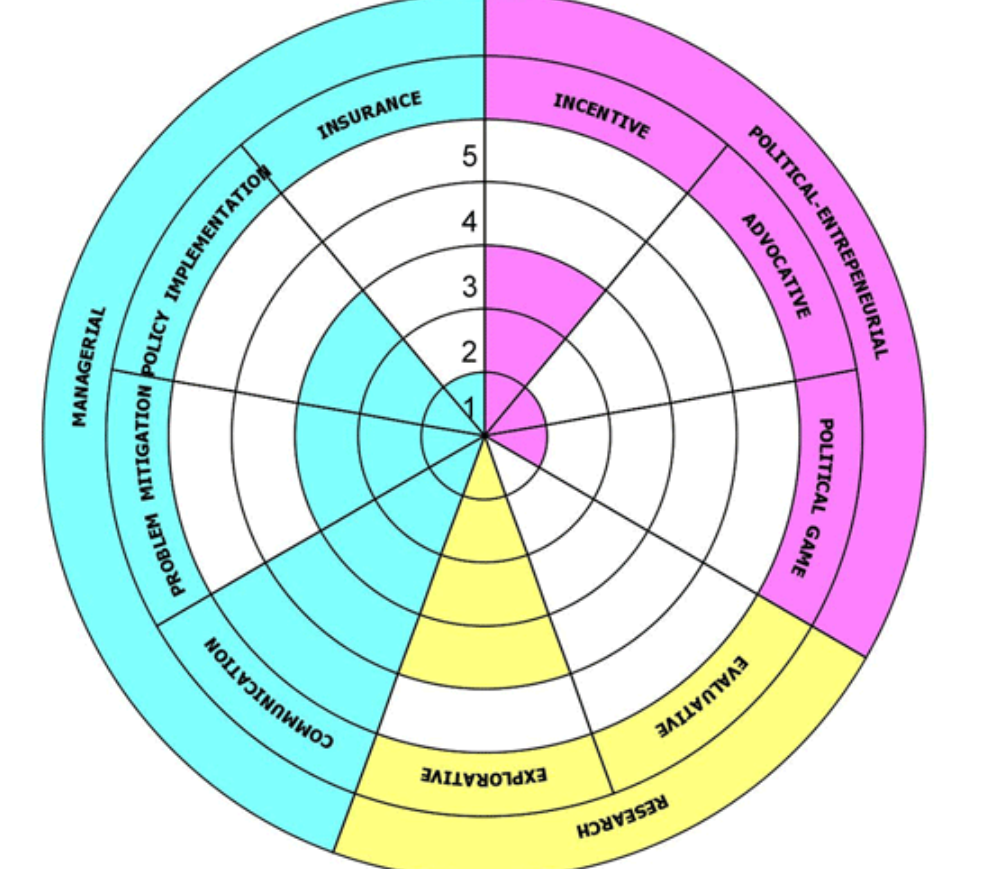
Fig. 3 . The nine uses of pilot projects within the Research, Managerial and Political-Entrepreneurial categories, depicted on a scale from 0 (absent) to 5 (strongly present) for the Combi-kering Den Helder pilot